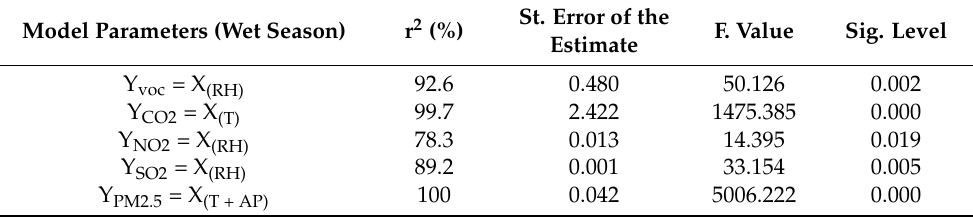
Table 4. Influence of meteorological parameters on air pollutant parameters (wet